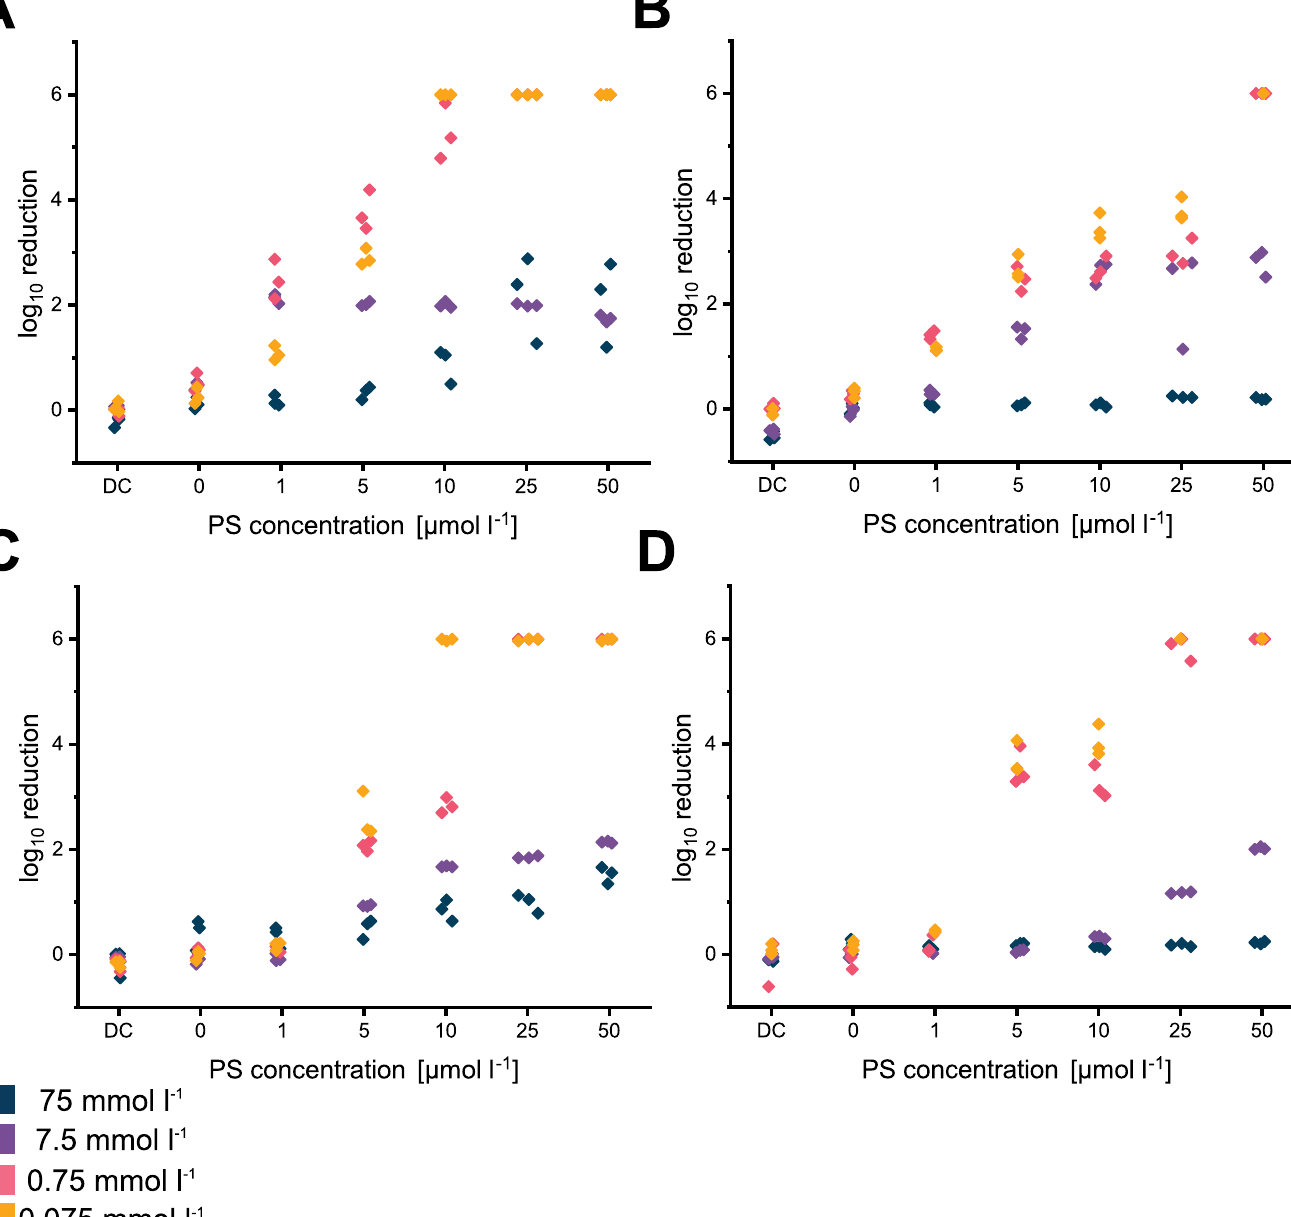
PLOS ONE | https://doi.org/10.1371/journal.pone.0253212 June 11,